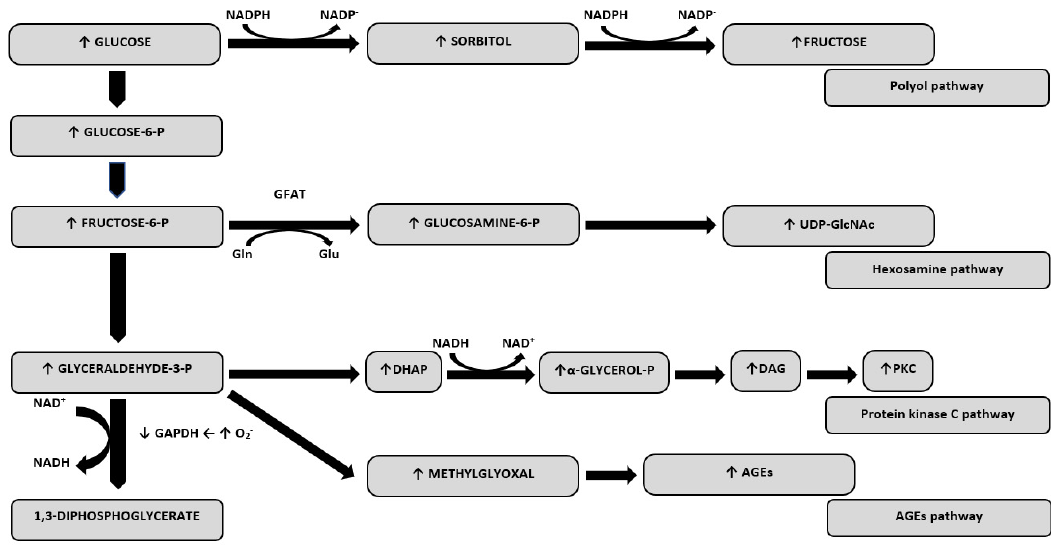
Figure 1. Oxidative stress-related pathways derived from